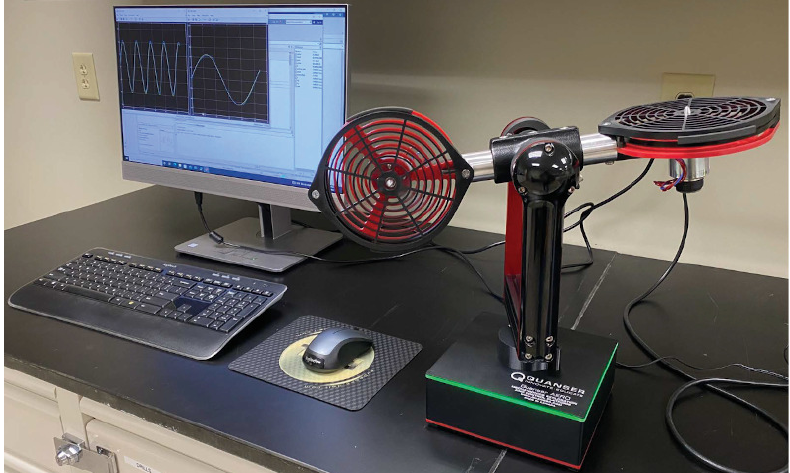
Figure 12. Quanser 2-DOF AERO 2-DOF helicopter system